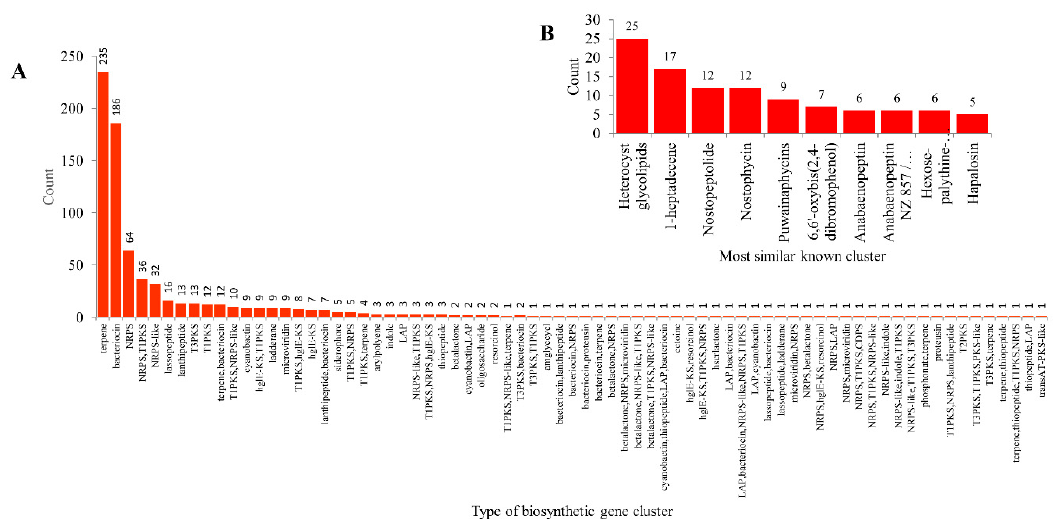
Figure 7. Comparative analysis of types of secondary metabolite biosynthetic gene clusters (BGCs) in 103 cyanobacterial species ( A ) and most similar known clusters ( B ). Standard abbreviations representing secondary metabolite BGCs as indicated in anti-SMASH (antibiotics & Secondary Metabolite Analysis Shell) [65] were used in the figure. Detailed information is presented in Supplementary Table S4.